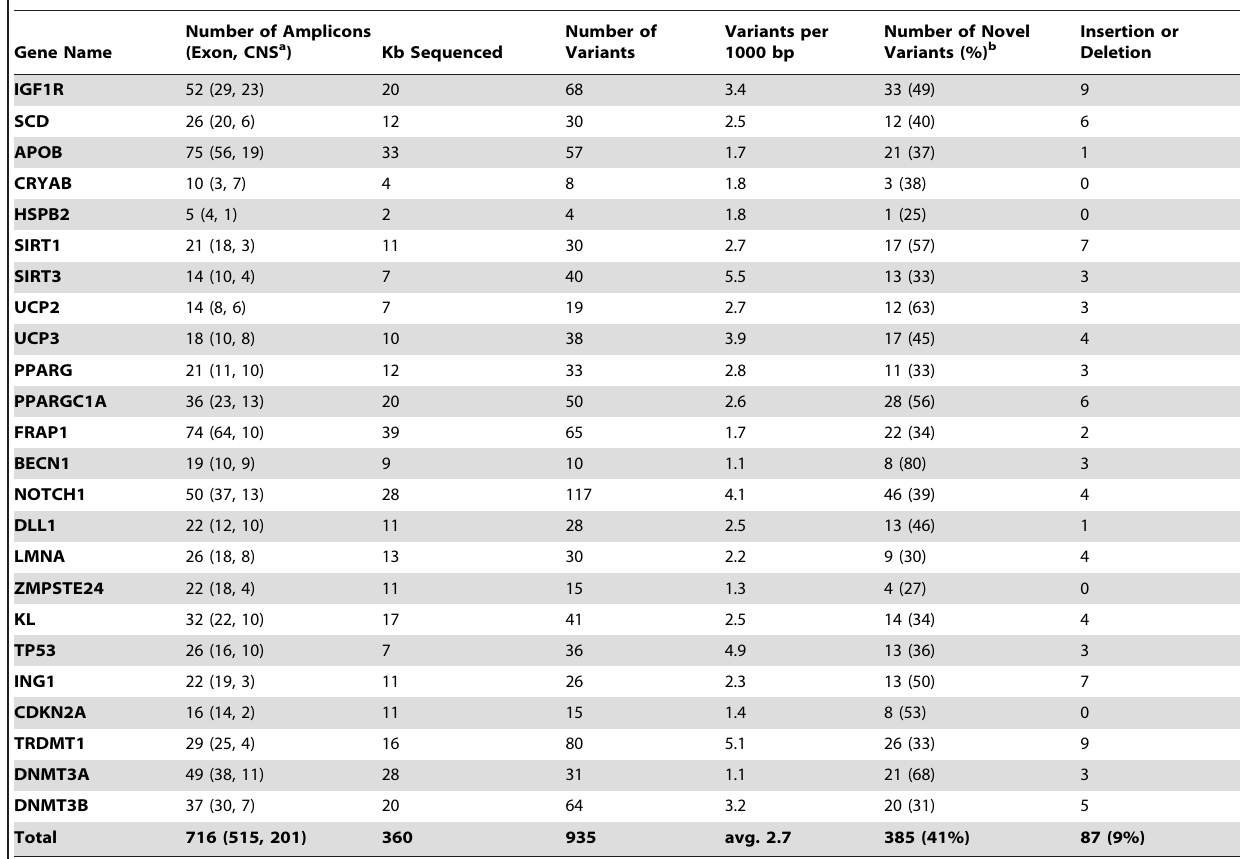
Table 2. Amplicon sequencing and variant